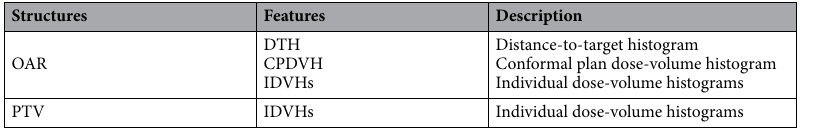
Table 2. The geometric and dosimetric features of the OAR and PTV used in this study. Each OAR has three features (DTH, CPDVH and IDVHs). The PTV has a single dosimetric feature (IDVHs).